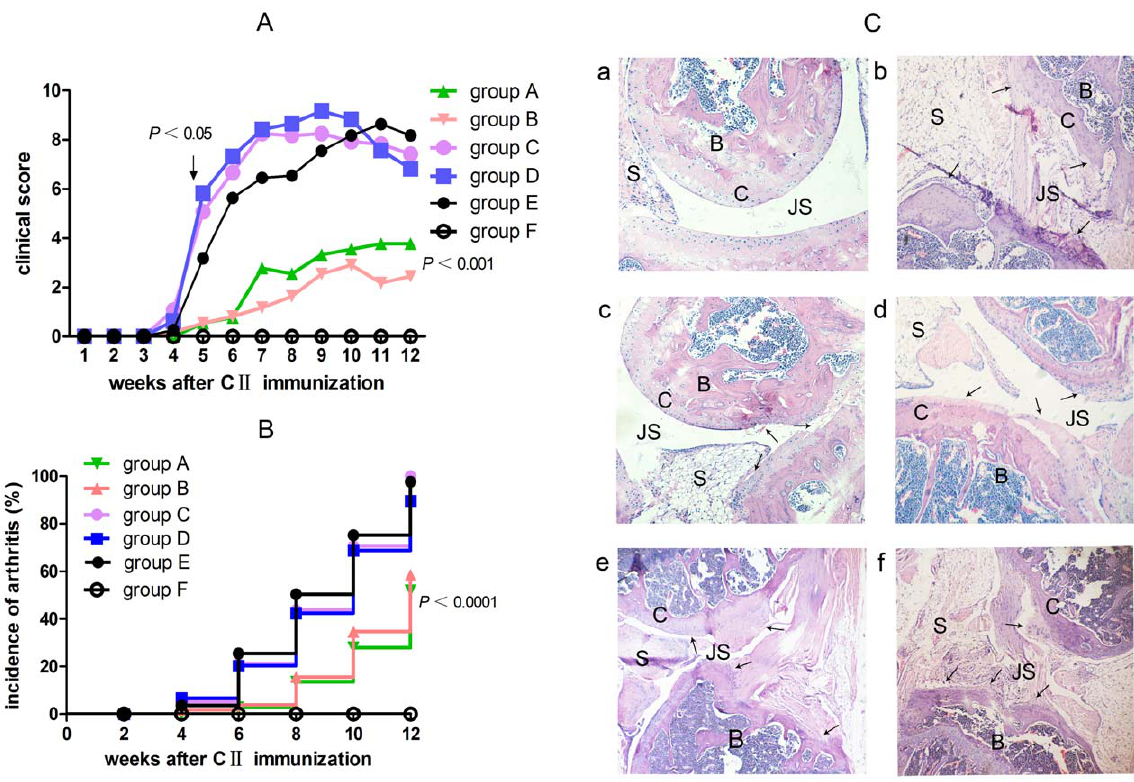
Figure 1. Effects of S.japonicum infection on the development of collagen-induced arthritis (CIA) in DBA/1 mice. Attenuated clinical manifestation of arthritis in prior S. japonicum infected mice. Mice were infected with S. japonicum 2 weeks prior to bovine type II collagen (CII) immunization or at the onset of disease. The severity (A) and incidence (B) of arthritis were assessed as described in Materials and Methods. Data are expressed as means of the total scores for four limbs or the incidence of arthritis after CII immunization. (n=12/group). Statistical analysis by one-way ANOVA with Bonferroni’s multiple comparison tests or by log-rank test of Kaplan–Meier survival curves. The clinical score of each mouse was recorded every day from 14 d after primary CII immunization. The onset of arthritis was about 28 d after CII immunization, and the peak time of the onset was around 33–35 d after immunization. The clinical score and the survival curve only differ significantly between prior schistosome-infected CIA mice and uninfected control mice. The diseases were exacerbated in the established CIA mice at one week after bisexual cercariae challenging. group A=unisexual S. japonicum infection prior to CII immunization; group B=bisexual S. japonicum infection prior to CII immunization; group C=unisexual S. japonicum infection post CII immunization; group D=bisexual S. japonicum infection post CII immunization; group E=uninfected CIA control mice, group E=age-matched normal control mice. (C) (a), A normal mouse and (b) a Type-II collagen (CII)-immunized uninfected mouse. Note the presence of severe synovial hyperplasia, mononuclear cell infiltration and angiogenesis, and the destruction of cartilage, focal fibrotic ankylosis and stenosis of articular cavity in the CII-immunized uninfected mouse. The arrows indicate an area of cartilage and bone (calcaneus) destruction. (c and d), Prior unisexual and bisexual S. japonicum infected CIA mouse. (e and f), Unisexual and bisexual S. japonicum infected in an established CIA mouse. Note the marked reduction of cell influx. Neither severe synovitis nor synovial hyperplasia was observed. Abbreviations: S. japonicum , Schistosoma japonicum ; CII, bovine Type-II collagen; B, bone (calcaneus); JS, joint space; C, cartilage; S, synovitis. Original magnification: 100 6 .